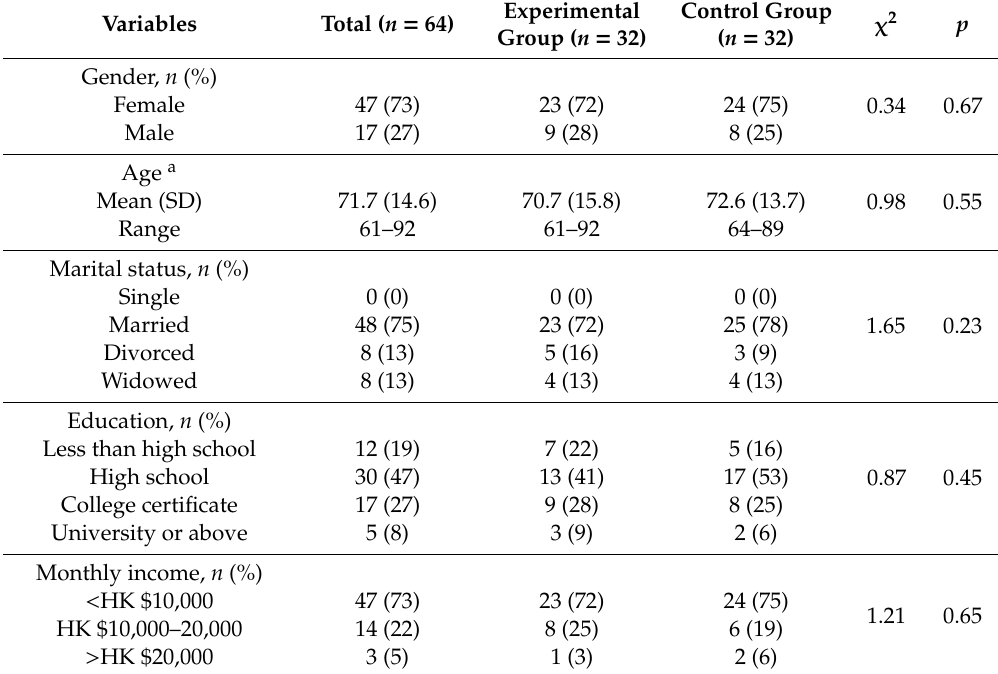
Table 1. Baseline demographic and clinical characteristics of the older